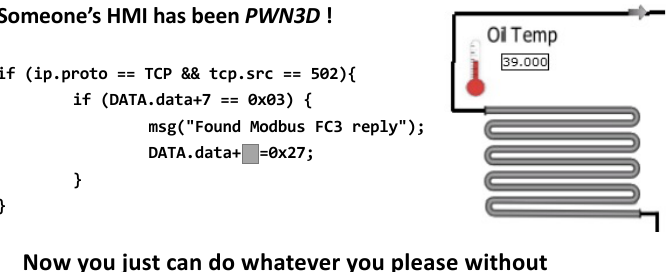
Figure 23. Injection of fake data into the HMI (byte offset deliberately